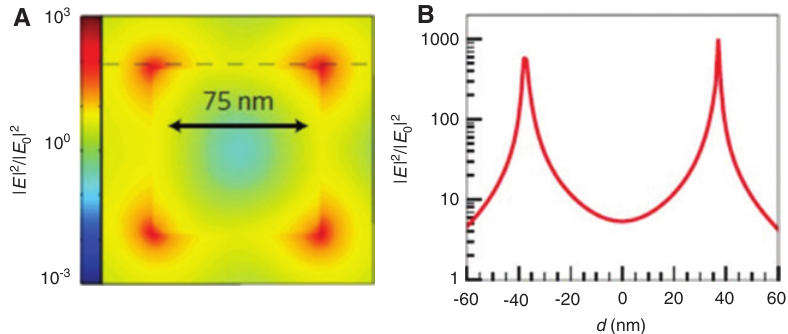
Figure 3: (A) Spatial distribution of the SPR-induced enhancement of electric field intensity at the SPR peak wavelength (420 nm), from a FDTD simulation of a 75-nm Ag nanocube. (B) Enhancement in the electric field intensity at the SPR peak wavelength as a function of dis- tance, d , along the dashed line. Reprinted by permission from Macmillan Publishers Ltd. Nature Materials [22], copyright 2011.